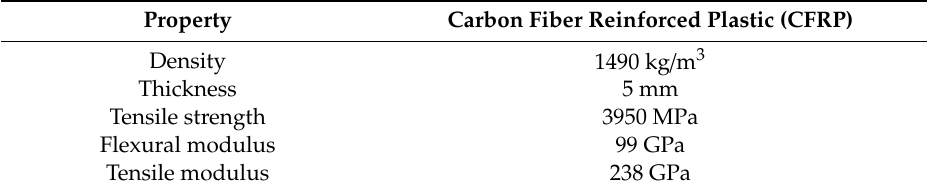
Table 1. Specifications of the workpiece